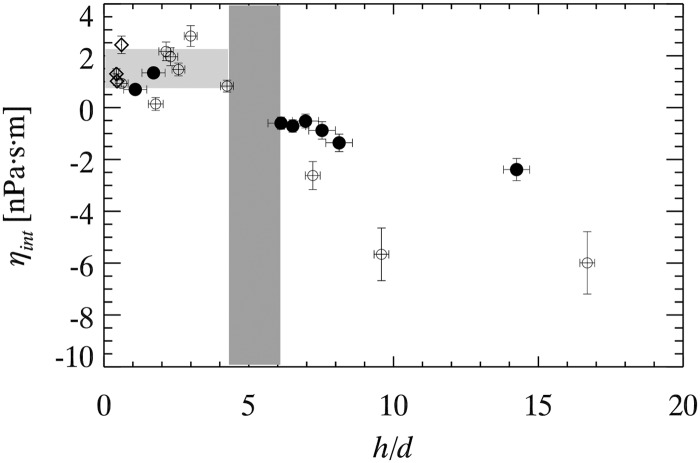
Plot of interfacial viscosity from single particle diffusion measurements as a function of h/d.Filled circles denote particles of diameter 0.1 μm, open circles denote particles of diameter 0.18 μm and diamonds denote particles of diameter 0.5 μm. The horizontal light shaded region represents η
int = 1.42±0.74 nPa⋅s⋅m based on the mean and standard deviation of the data for h/d < 5. The vertical dark shaded region represents the crossover from physical behavior at small h/d to unphysical behavior at h/d > 5.2±0.9. The horizontal error bars are due to uncertainties of h, and vertical error bars are due to uncertainties of h and η
2D (see Eq 4).